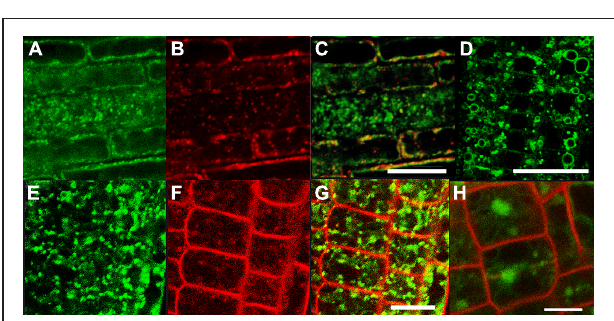
FIGURE 3 | The compartment labeled by CAT9–GFP in roots. Punctuate fluorescence labeling of pCAT9:: CAT9–GFP ( A , green) and ARA7-mRFP ( B , red) and partial overlap (C) . CAT9–GFP fluorescence after concanamycin A treatment (100 nM for 30 min, D ). Punctuate pUbq10:: CAT9–GFP fluorescence (E) , FM4-64 ( F , 15 min. after addition, red), and partial overlap (G) . Aggregation of the green CAT9–GFP fluorescence into one or two spots per cell after brefeldin A treatment for 2 h ( H , red: propidium iodide). Scaling bars: (A–H) : 20 μ m.